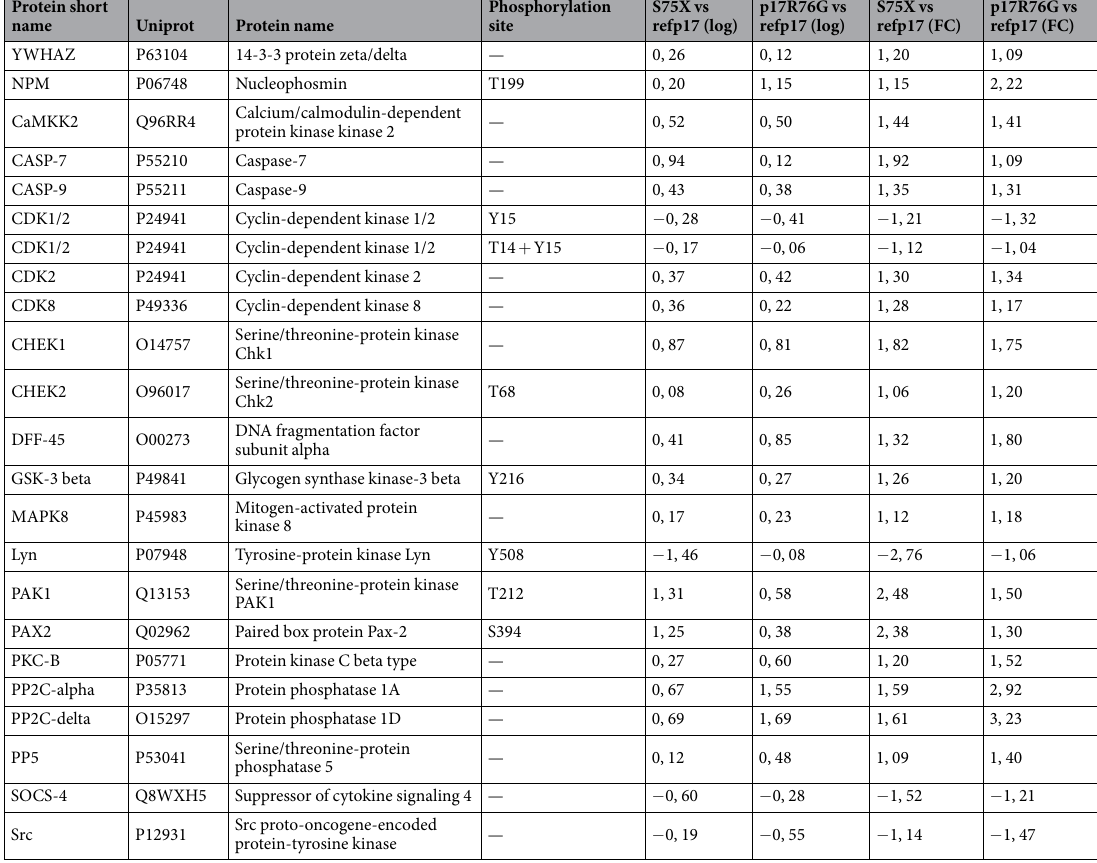
Table 2. Effect of S75X and p17R76G on expression and phosphorylation levels of intracellular signaling proteins. The protein expression and phosphorylation level were analyzed from Kinexus Bioinformatic Corporation by densitometric analysis of multi-immunoblotting. Blot raw quantification data were processed by log transformation and normalization to either not treated or p17 treated samples for the interpretation of the results. The numerical values refer to log2-ratio with respect to refp17 values. FC = Fold